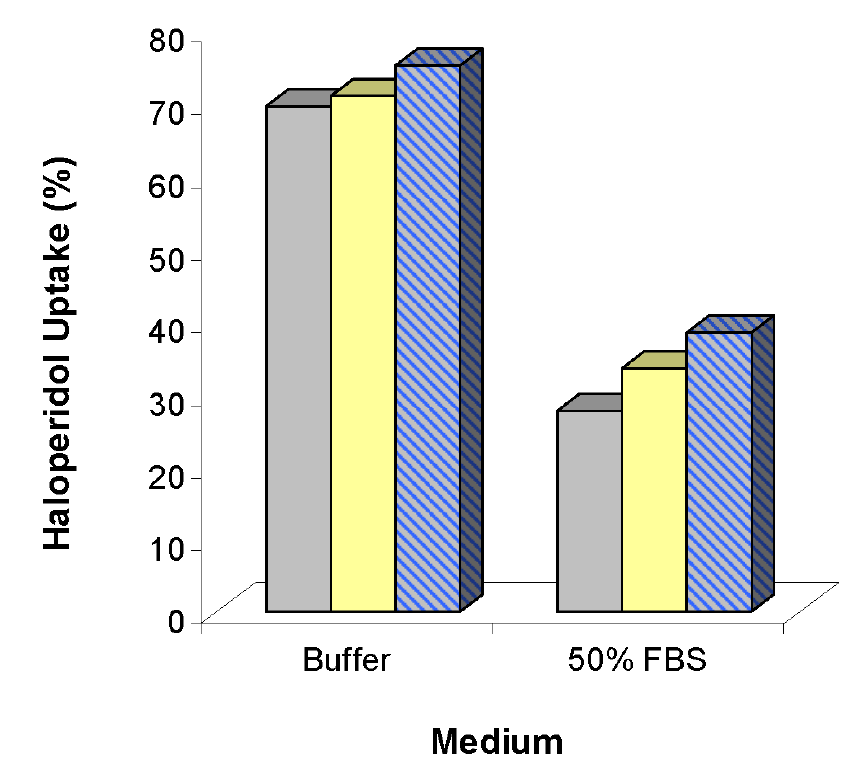
Figure 2. Haloperidol uptake by multilamellar ( ) and unilamellar ( ) liposomes and spherulites ( ) in the presence and absence of 50% fetal bovine serum (FBS), adapted from Dhanikula et al. [31] with